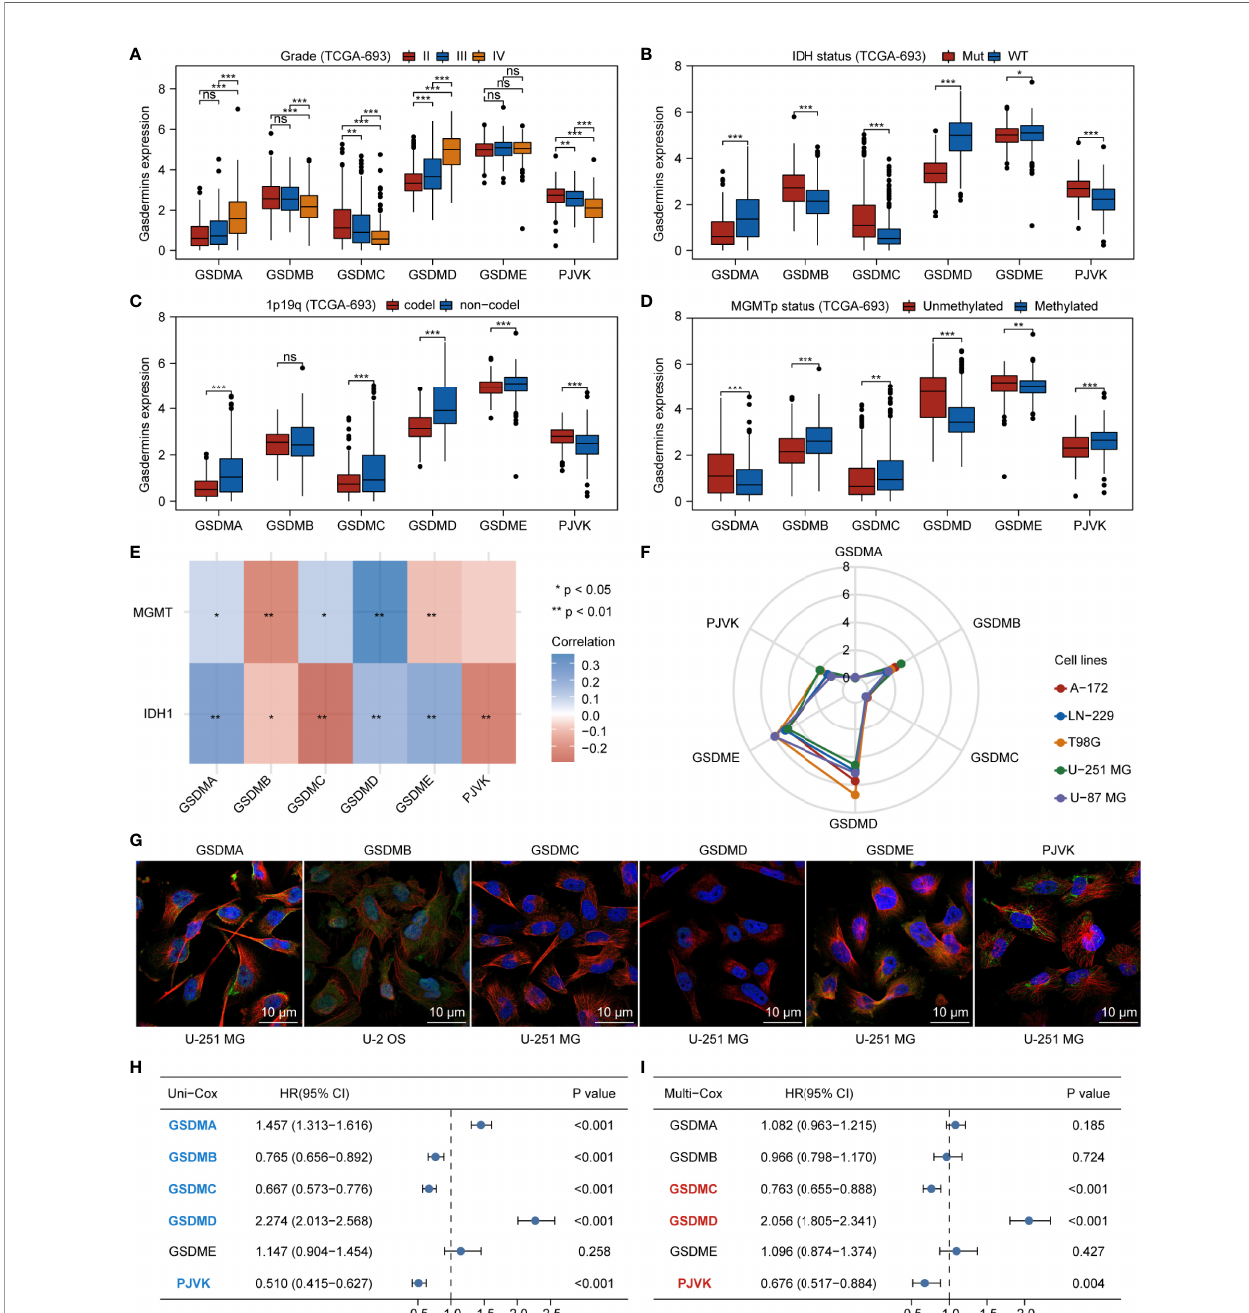
FIGURE 1 | Aberrant expression and prognostic value of gasdermins in glioma. Boxplots showing comparison of gasdermin expression in different grades (A) , IDH mutation statuses (B) , 1p19q codeletion statuses (C) , and MGMT -promoter methylation statuses (D) of glioma samples. (E) Heatmap showing correlation between gasdermin expression and IDH1 or MGMT expression. (F) Radar plot showing gasdermin expression in different glioma cell lines. (G) The results of immuno fl uorescence from HPA database showing the subcellular distribution of the gasdermin protein. (H, I) Forest plots showing the results of univariate and multivariate Cox regression analyses for gasdermins. *P<0.05; **P<0.01; ***P<0.001; ns, not signi fi